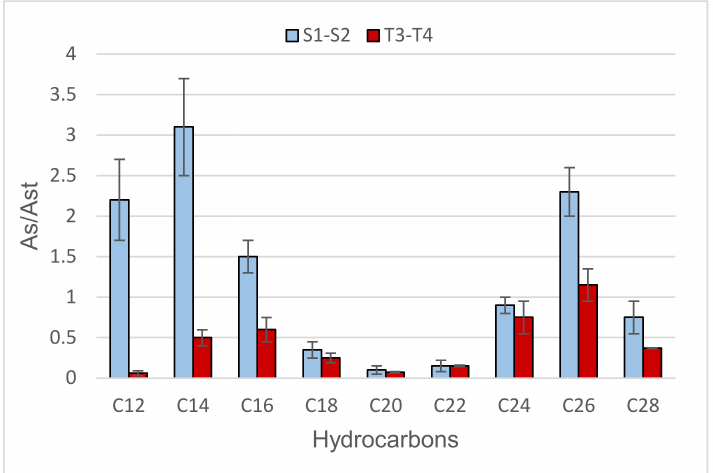
Figure 2. Results obtained from the semi-quantitative analysis of hydrocarbons (chain length: 12–28 C atoms) in supply water (S1 and S2 in light blue) and treated water (T3 and T4 in red) in sampling II. As/Ast represents the ratio between the hydrocarbon peak areas in the sample and in the reference